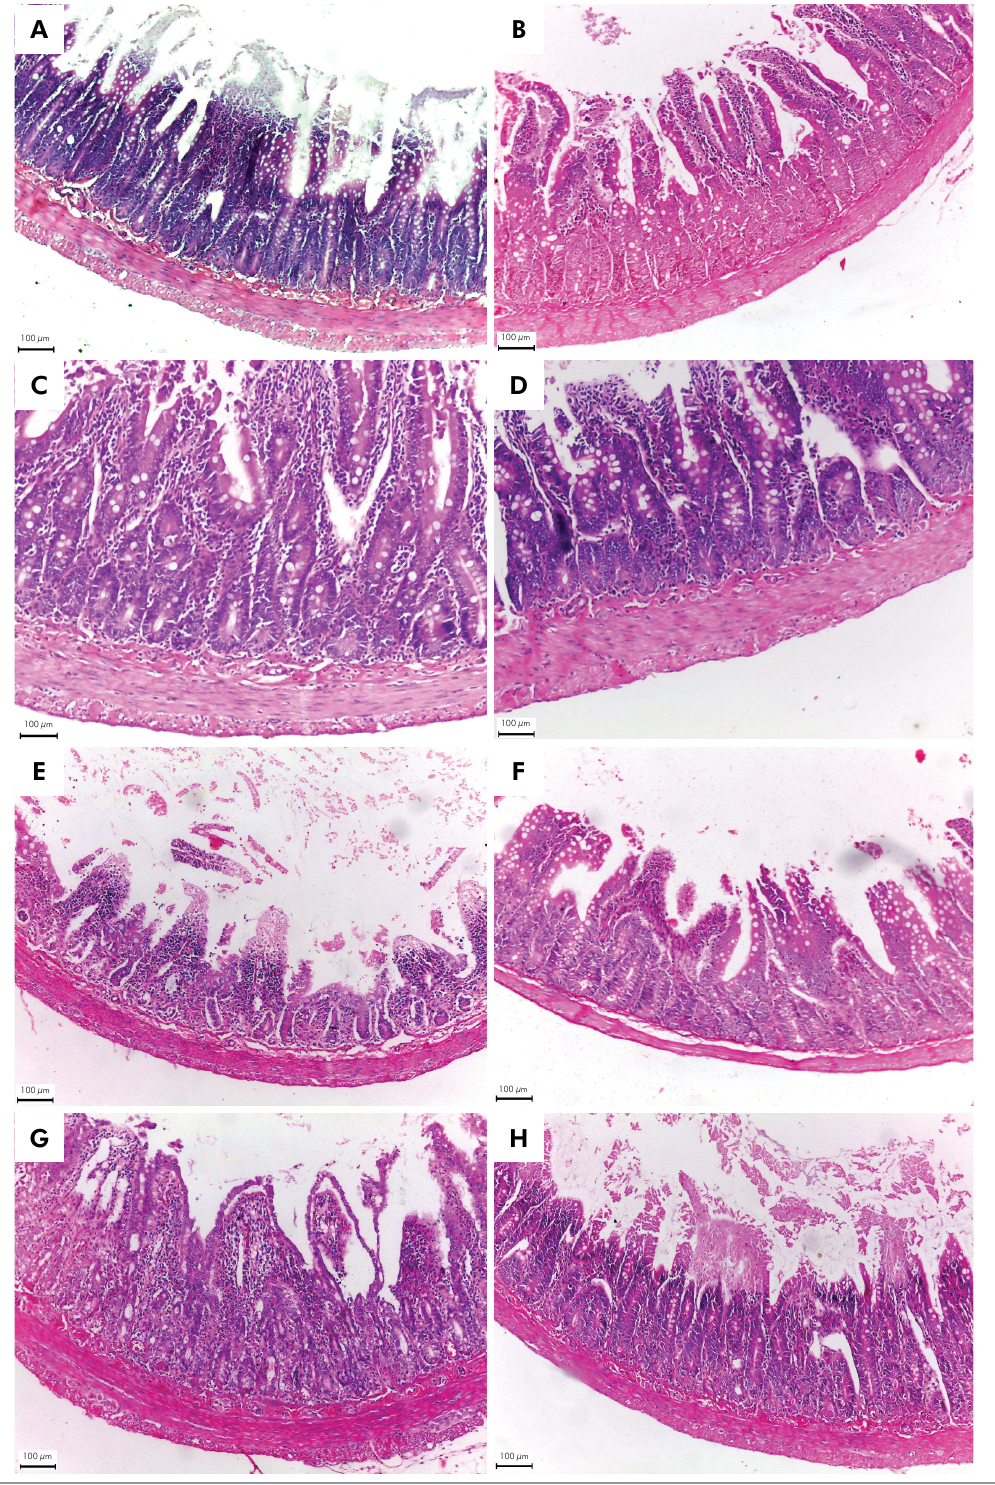
Figure 4. Light microscopy of the small intestine. Groups GC (A and B) and GPROB (C and D) - Normal intestinal mucosa. Group G5-FU: E - Moderate submucosal lymphocytic infiltration with destruction of villous surfaces; F - Intestinal mucosa with discreet submucosal lymphocytic infiltration. Group G5-FU/PROB: G - Intestinal mucosa with moderate submucosal lymphocytic infiltration and areas with superficial villus destruction; H - Normal intestinal mucosa. The left column shows assessment at day 3, whereas the right column shows assessment at day 7. Hematoxylin-eosin, 100x